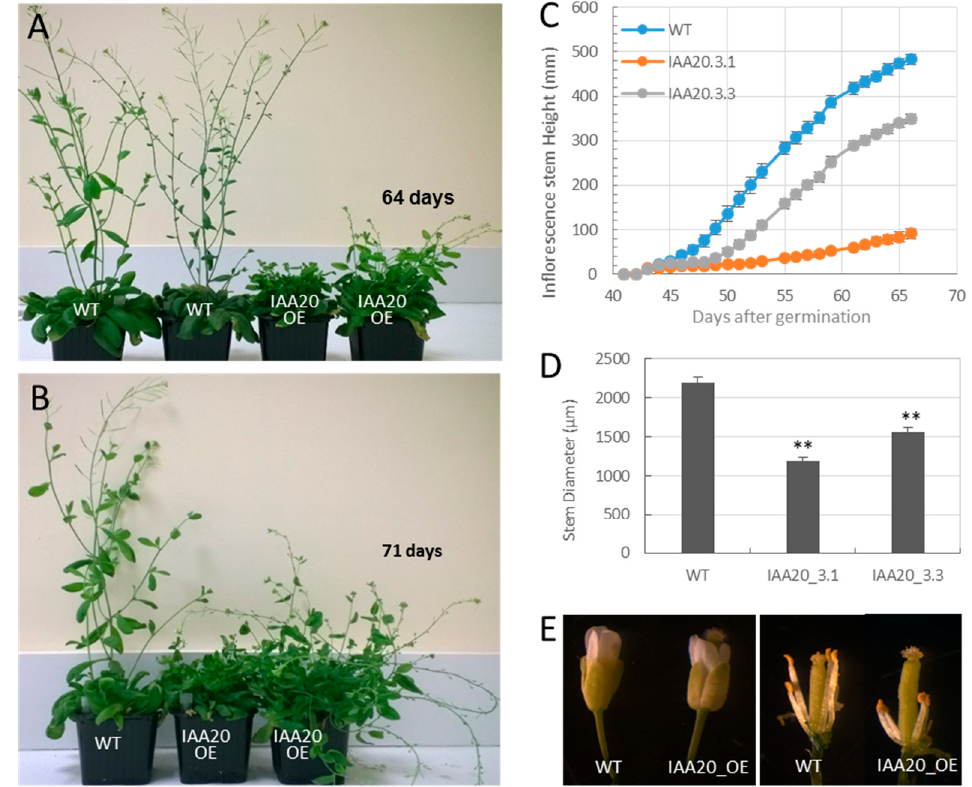
Figure 5. Phenotypes of EgrIAA20 overexpressing lines. Comparison of plant architecture of aerial parts at 64 days old ( A ) and 71 days old ( B ); EgrIAA20 overexpressing lines displayed a bushier plants architecture compared to the normal plant, with floppy inflorescence stems, in contrast to wild-type control up-right growth inflorescence stems. ( C ) Growth curve of the Arabidopsis primary inflorescence stem. The elongation was reduced in EgrIAA20 overexpressing lines with significantly reduced inflorescence diameter ( D ); error bars represent standard error, n > 12; stem diameter was measured at the base (<1 cm to the rosette level) when the first silique fully developed. Asterisks indicate values found to be significantly different (student’s t -test, n > 12) from the wild-type control. ** indicates p < 0.01. ( E ) The stamens of EgrIAA20 overexpressing lines were dramatically shorter than the wild-type control.